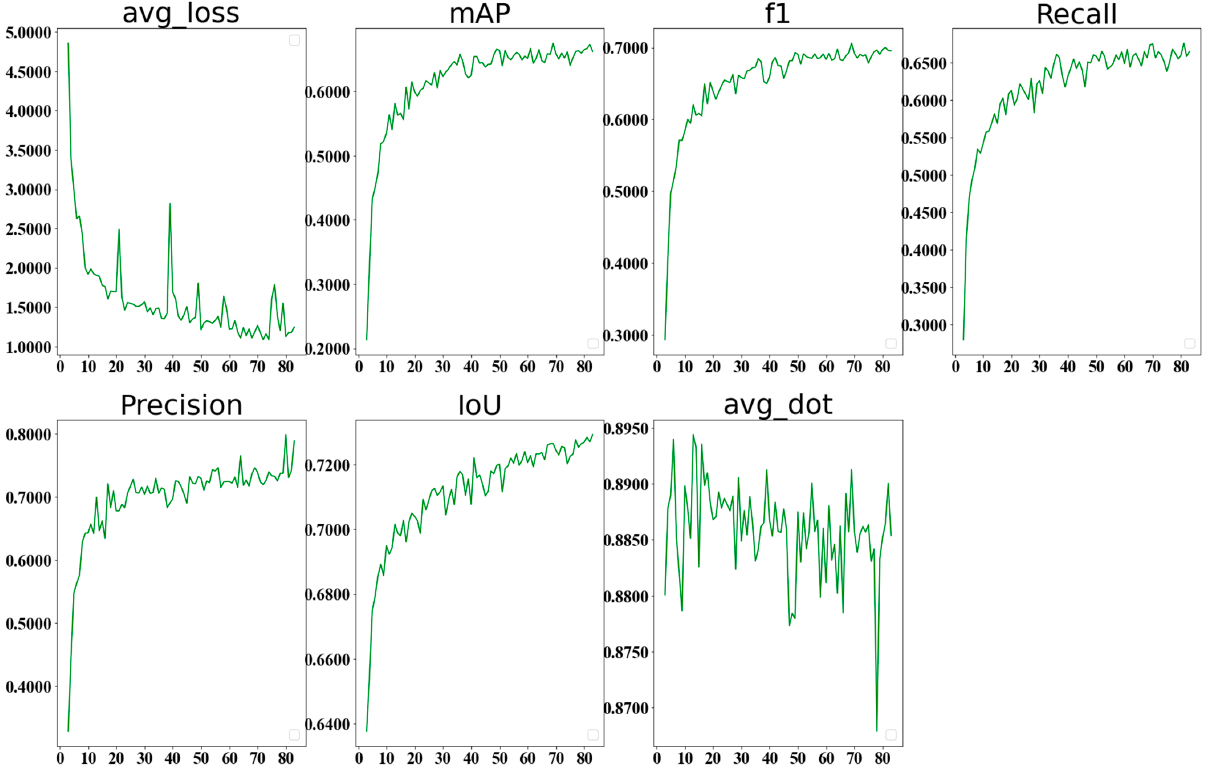
Figure 8. The changes of various indexes of DOTA1.5 dataset during iteration.